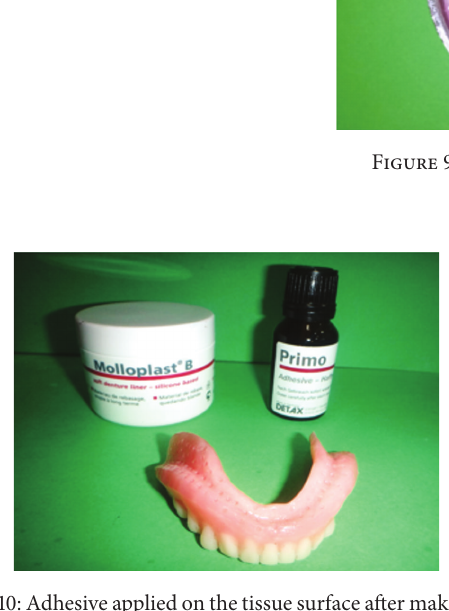
Figure 10: Adhesive applied on the tissue surface after making holes 1mm in diameter 2-3 mm apart from each